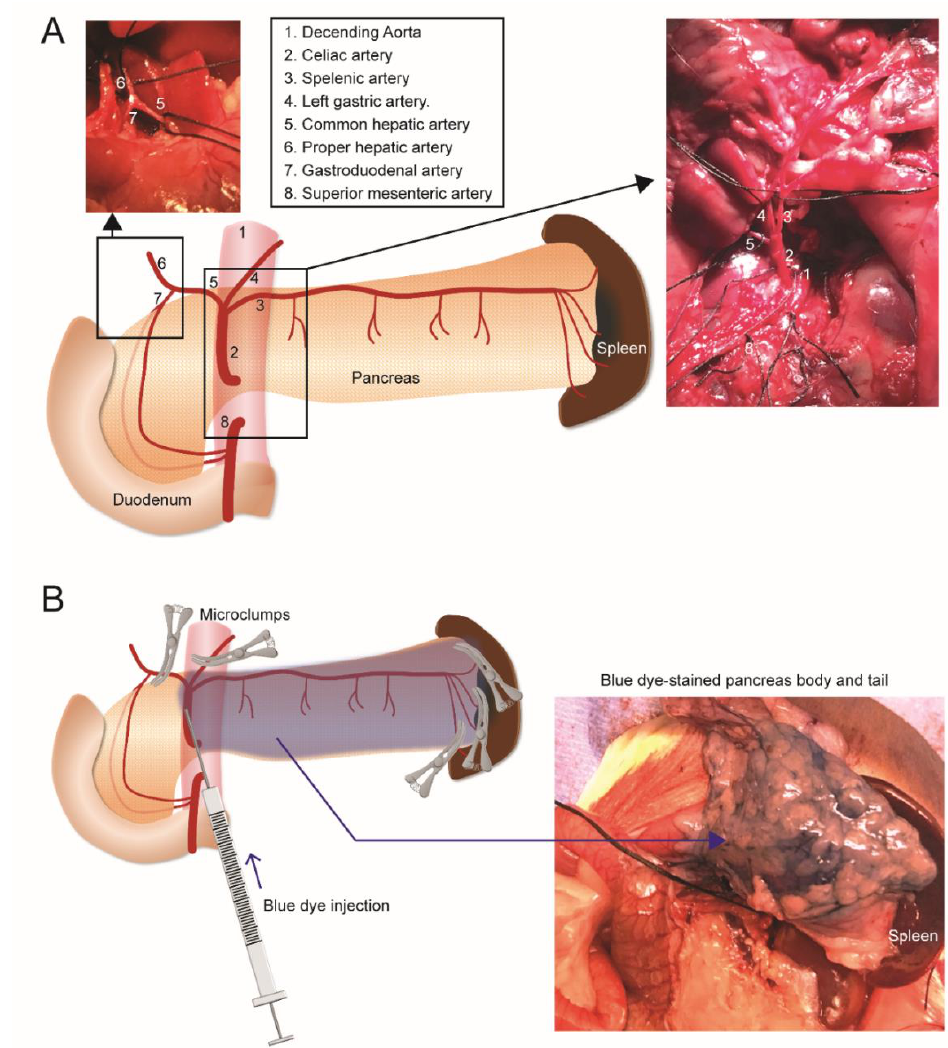
Figure 5. Intra-arterial injection procedure. ( A ) Anatomy of arteries around pancreas. The schema illustrates the description of the arteries, and two photographs show the dissected key arteries. Arteries were looped with black silk sutures. ( B ) Injection procedure. To specifically distribute the injected solution (blue dye in the preliminary tests or [ 124 I]I-UC-MSC-EVs for PET imaging), common hepatic artery, left gastric artery, and terminal branches of splenic arteries were clumped. A needle was cannulated into the Celiac artery to inject the solution. Microclumps were released after the injection was completed.